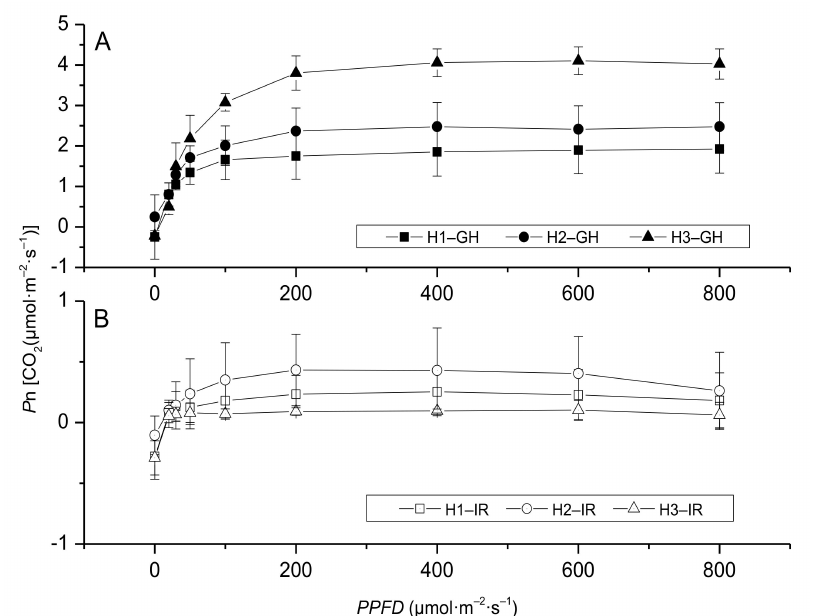
Figure 3. Light–response curves of Anthurium × ‘Red’ grown in a shaded greenhouse under a high light level (550 µ mol · m − 2 · s − 1 ) before ( A ) and after ( B ) placement to interior rooms. Where H: high light level, IR: interior room, and numeric values 1, 2, and 3 represent the bottom old leaf, center mature leaf, and the top young expanded leaf,